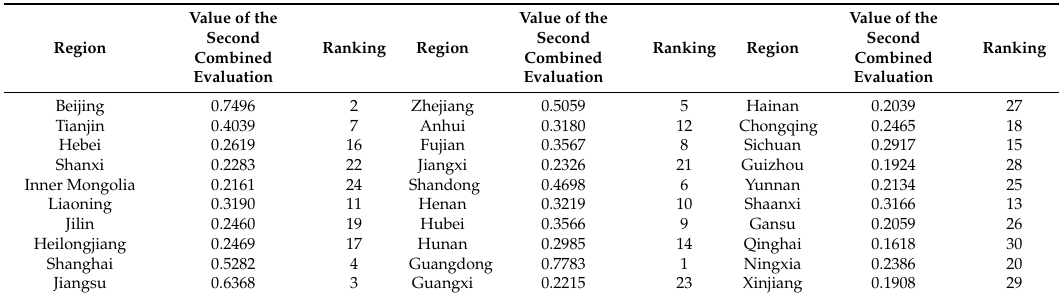
Table 6. The second combined evaluation